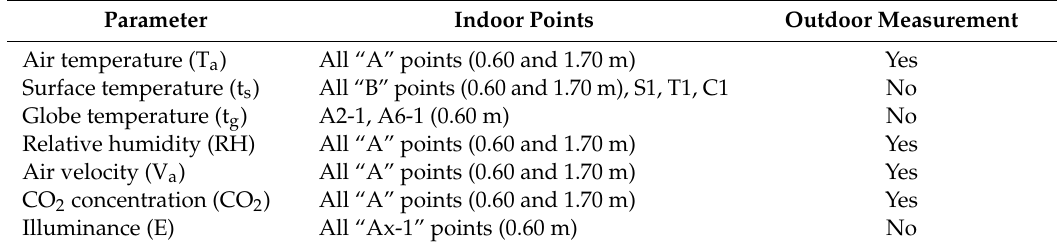
Figure 3. The 3-D array of measurement points superimposed in a multipurpose classroom. Red dots show values at 0.6 m, dark red dots at 1.7 m, orange dots represent measures in the room’s envelope, and blue dot is the window. Table 2. Acquisition points per physical parameters measured.